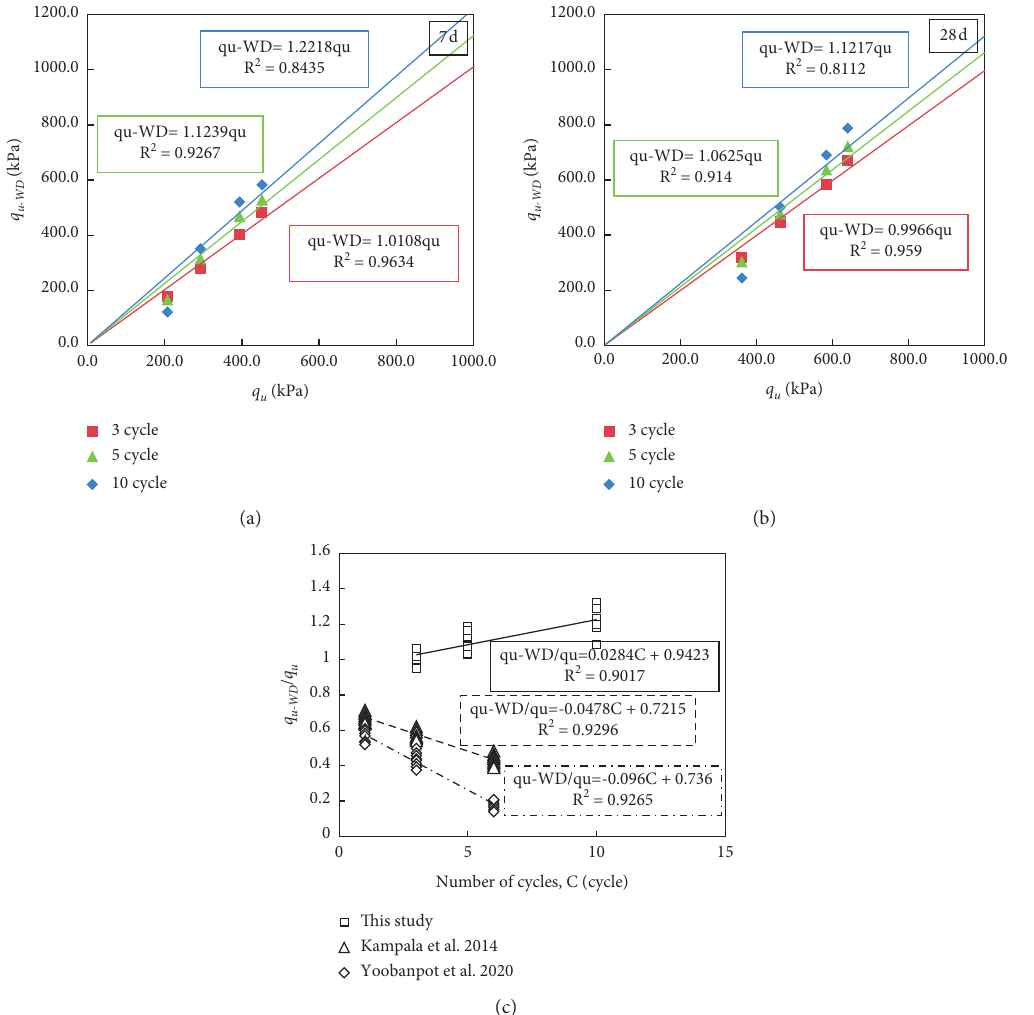
Figure 8: Relationship between the W-D cycle strengths and q and number of